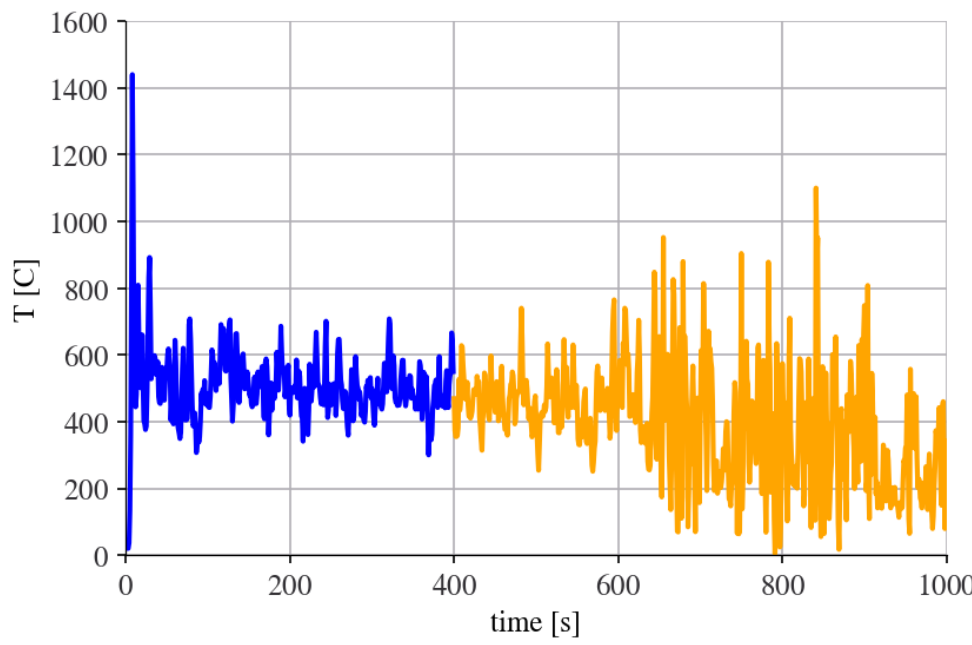
Figure 9. Comparison between computational temperature reading and time forecasting with the ARIMA model.